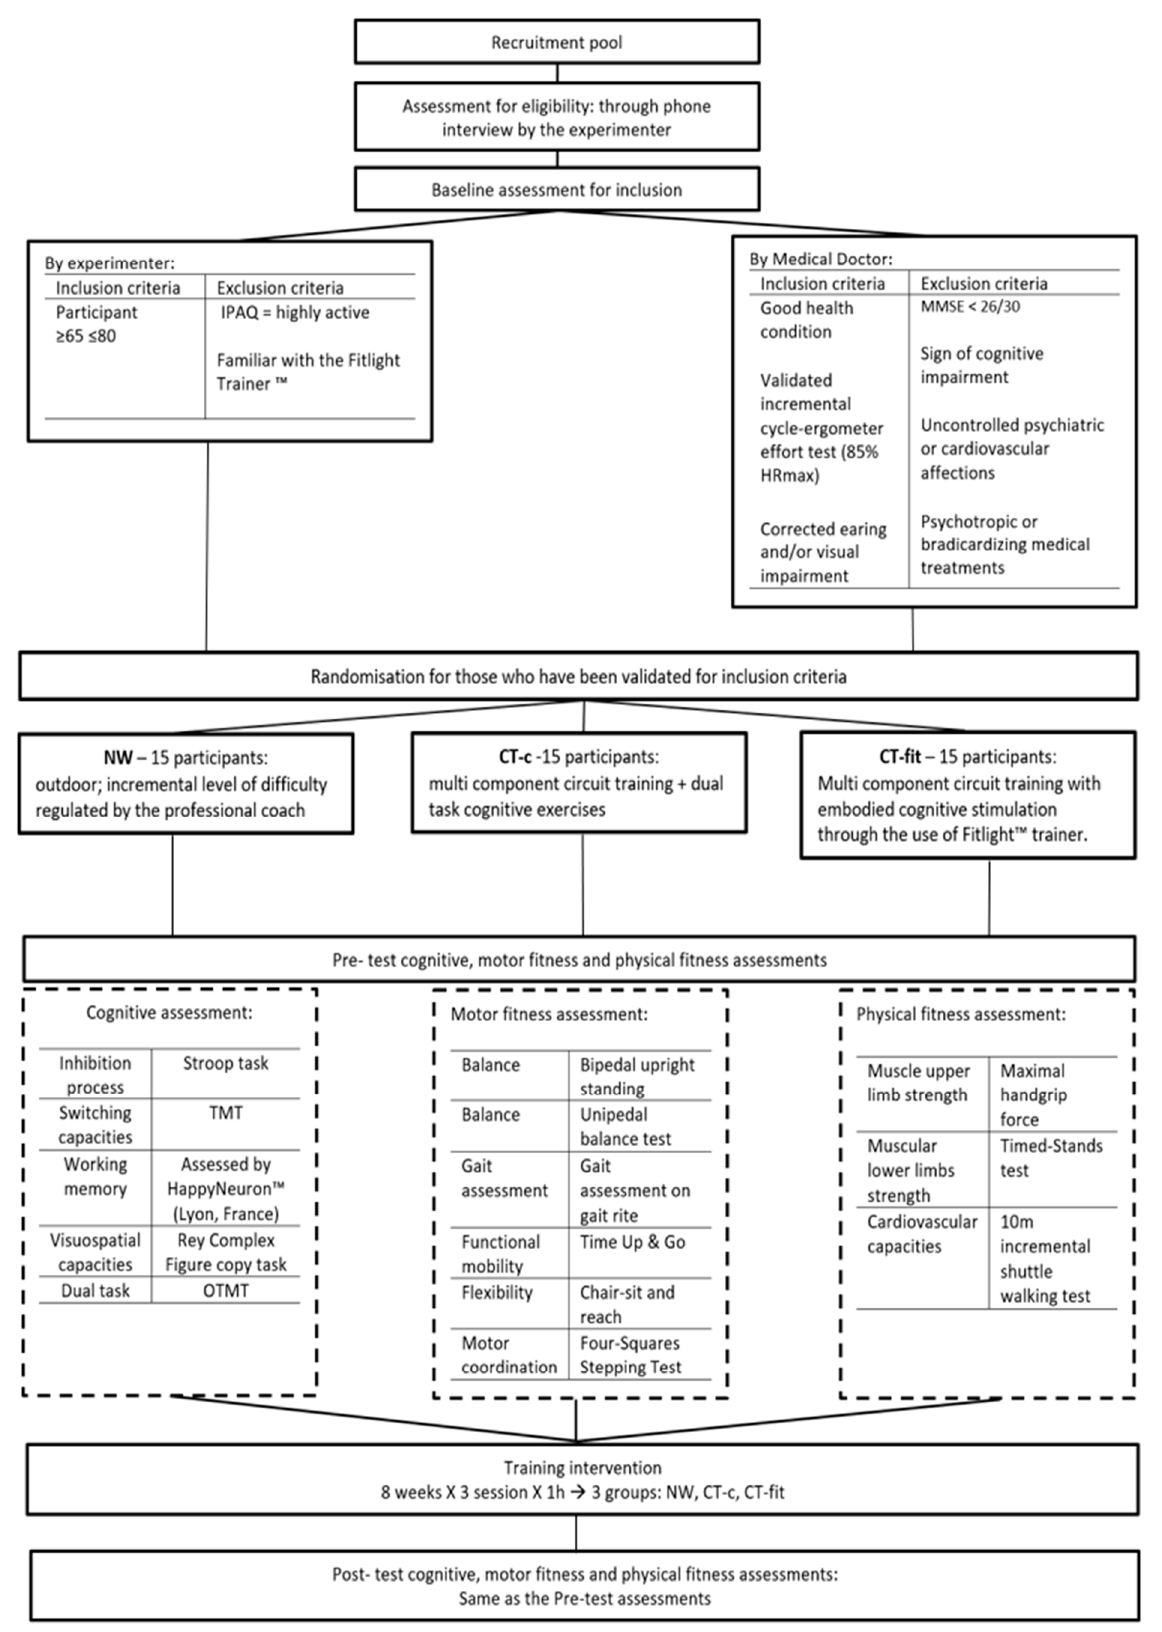
Figure 1. Participant’s flow chart. Participant’s flow chart (IPAQ = International Physical Activity Questionnaire; TMT = Trial Making Test; OTMT = Oral Trial Making Test).